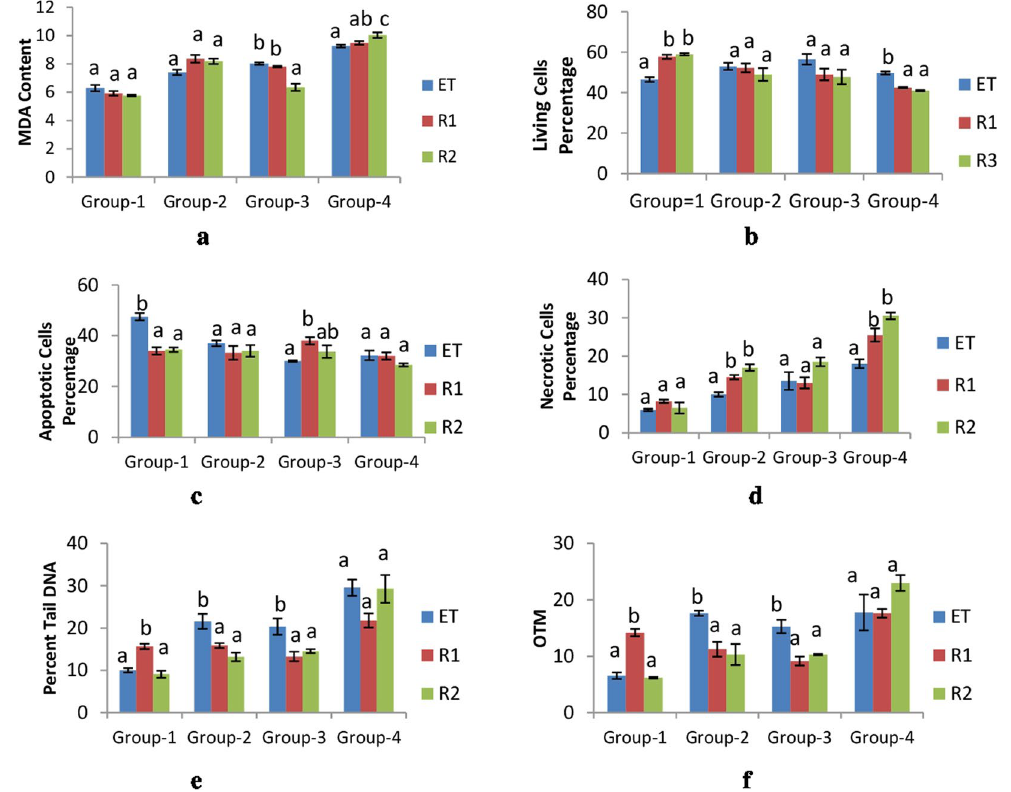
Figure 3. ( a – f ) Represent the MDA content, Living Cells, Apoptotic Cells and Necrotic Cells Percentage, Percent Tail DNA and OTM in different exposure time and recovery groups.Group-1 = Exposure Time 24 hr, Group-2 = Exposure Time 48 hr, Group-3 = Exposure Time 72hr, Group-4 = Exposure Time 96 hr, ET = Exposure time, R1 = Recovery after 1 day, R2 = Recovery after 2 days. Different letters a, b, c, signify the difference between exposure time group and recovery groups. Error bars represent the standard error. The same letters indicate homogenous groups.